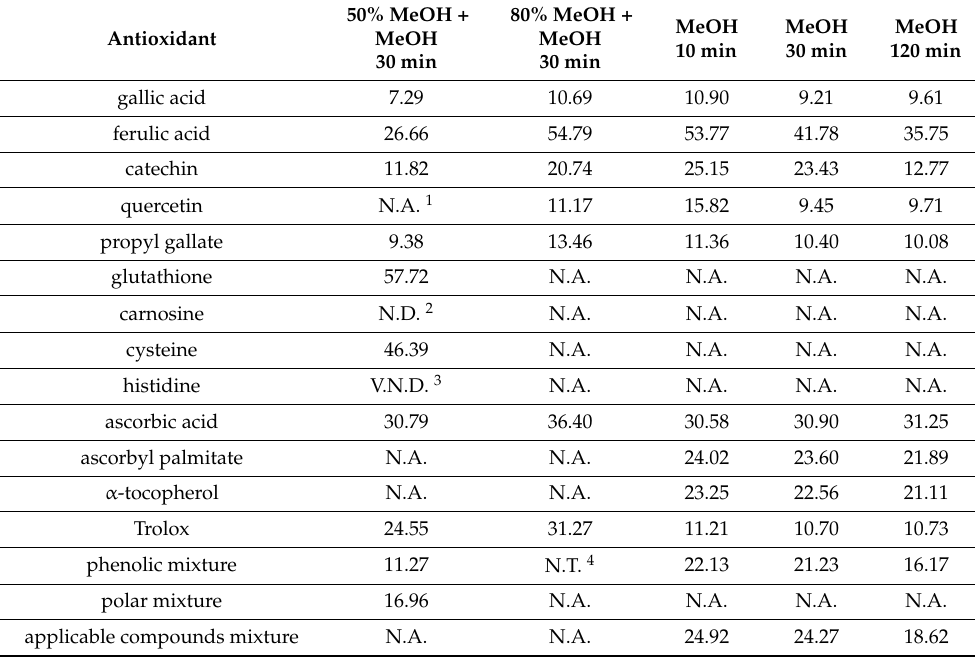
Table 7. IC 50 values ( µ M) determined against DPPH radicals applied in methanol or aqueous methanol after standard and modified reaction times (radical solution in